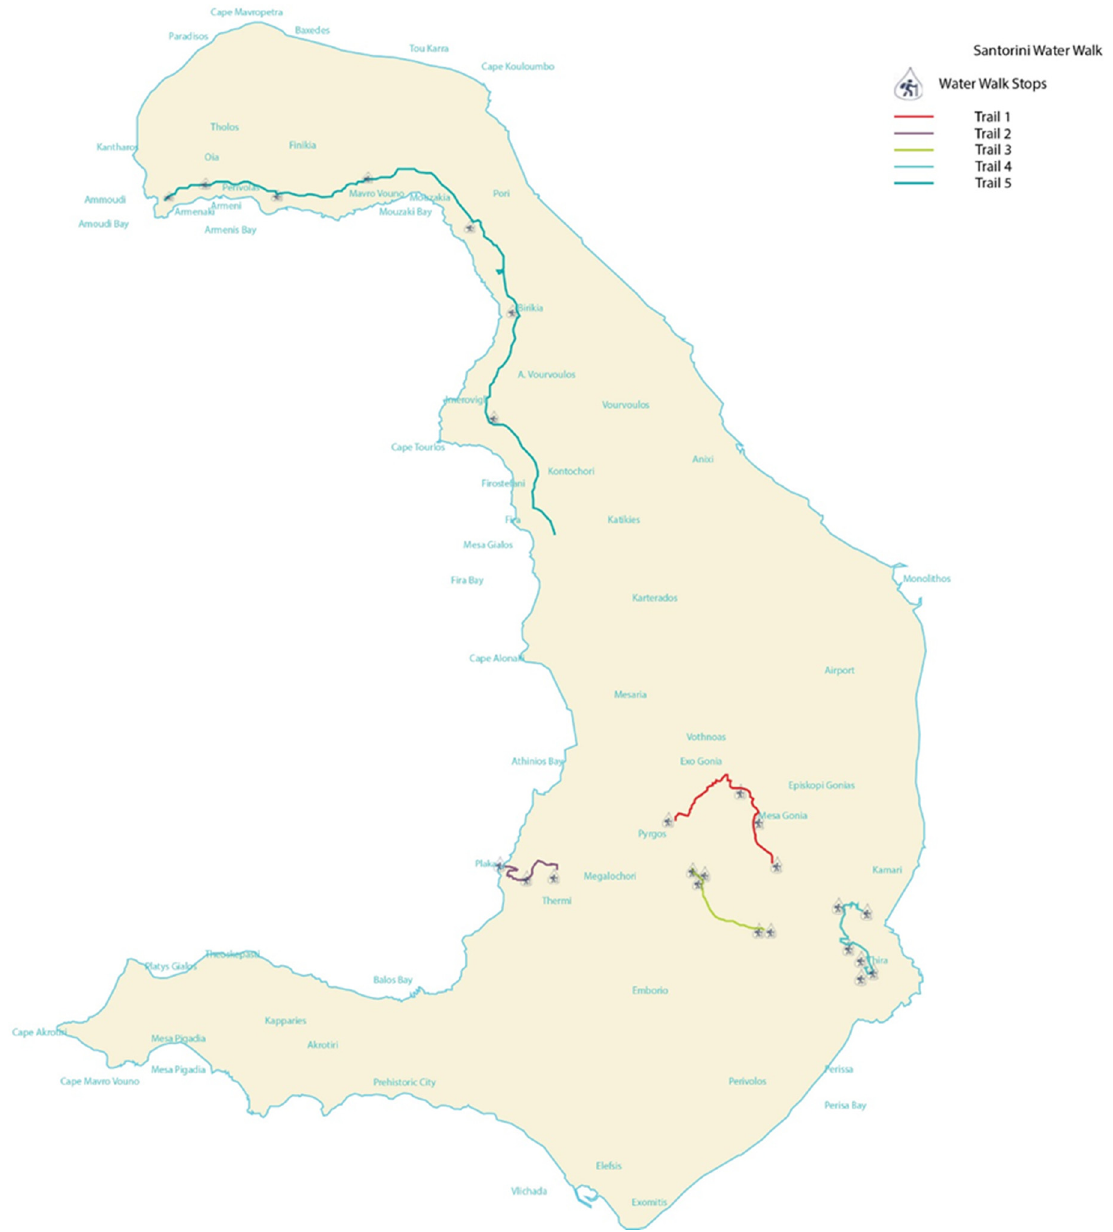
Figure 5. Map of proposed water walk stops and trails. Map prepared by Laura Kenny.